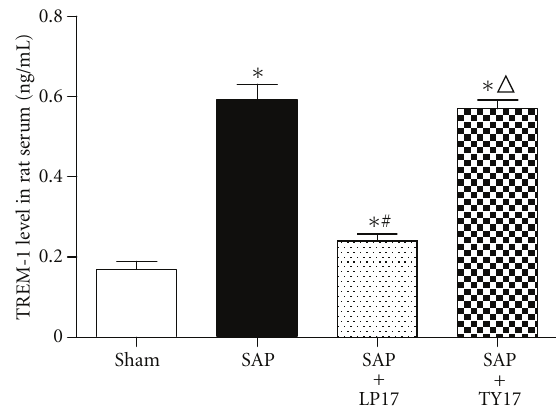
Figure 1: Levels of TREM-1 in serum in each group. ∗ P versus sham group, # P versus SAP group, Δ P versus SAP + LP17 group ( P < 0 . 05, as